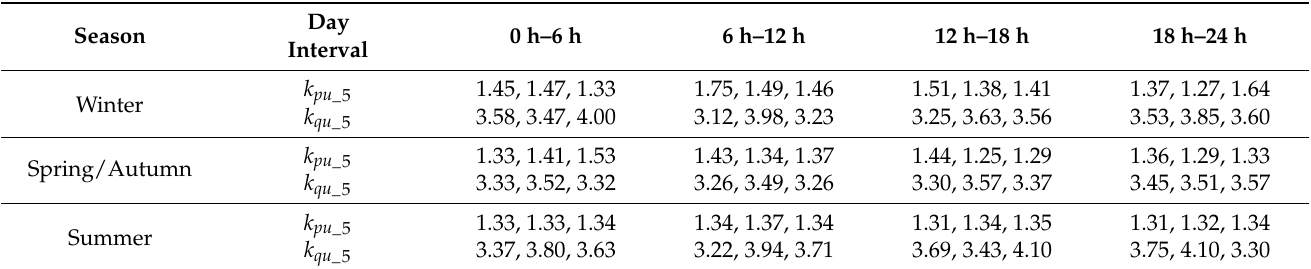
Table 5. Parameters k pu and k qu in different seasons and day intervals calculated from five average meteorological variables ( k pu_ 5 and k qu_ 5 ), of a working weekday, Saturday, and Sunday, listed